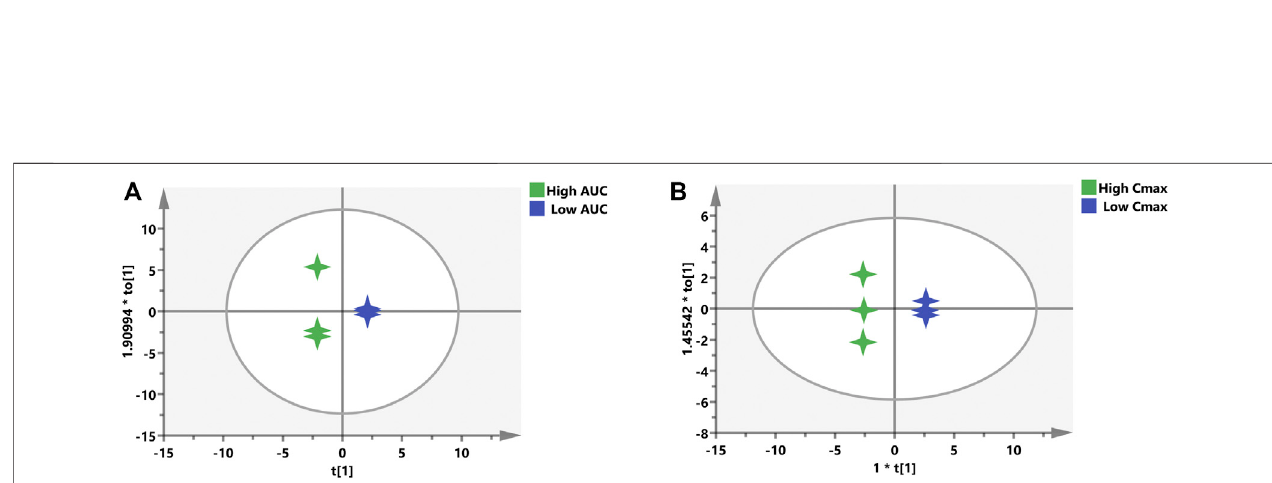
FIGURE 8 | OPLS-DA models to discriminate the subgroups based on the screened biomarkers. Each 4-point star represents a rat. Green stars indicate rats with high AUC (A) or C max (B) , while blue stars mean rats with low AUC (A) or C max (B) .